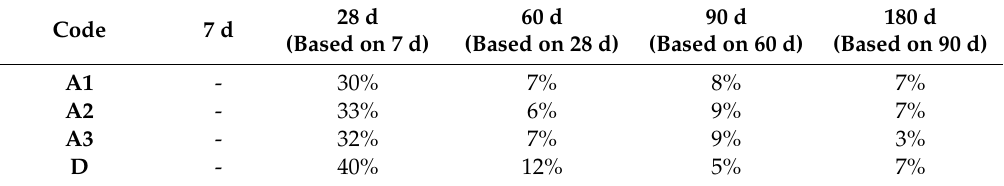
Figure 5. Relationship between the UCS and curing time. Table 5. The growth rate (%) of UCS at di ff erent